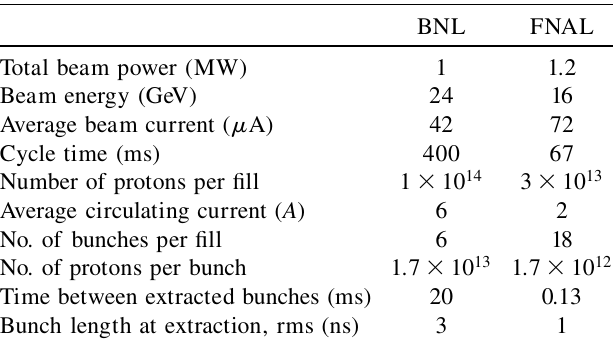
TABLE VI. Proton driver parameters for BNL and FNAL